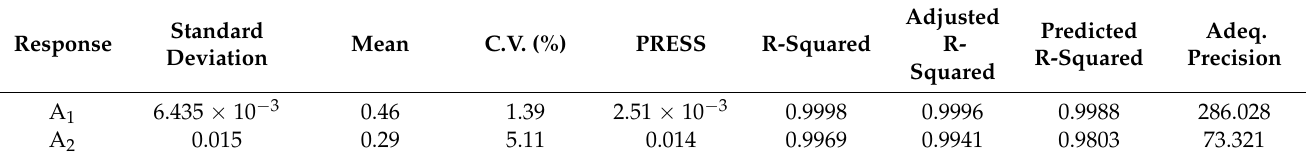
Table 4. Error statistical analysis of the regression